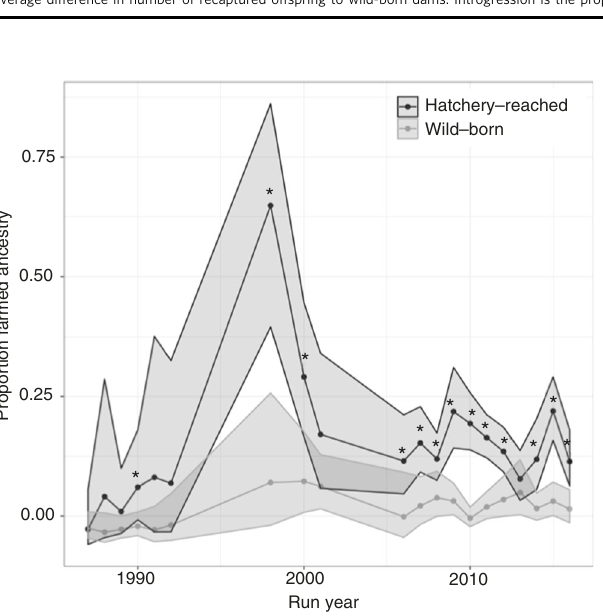
Eachcolumngivesthe parameterestimates±standarderrorforeachparameterinthetwo modelsandthelastrowgivesthedifferenceinAICscore.Theeffectof hatcherybackgroundindamsgivesthe average difference in number of recaptured offspring to wild-born dams. Introgression is the proportion of farm ancestry in broodstock